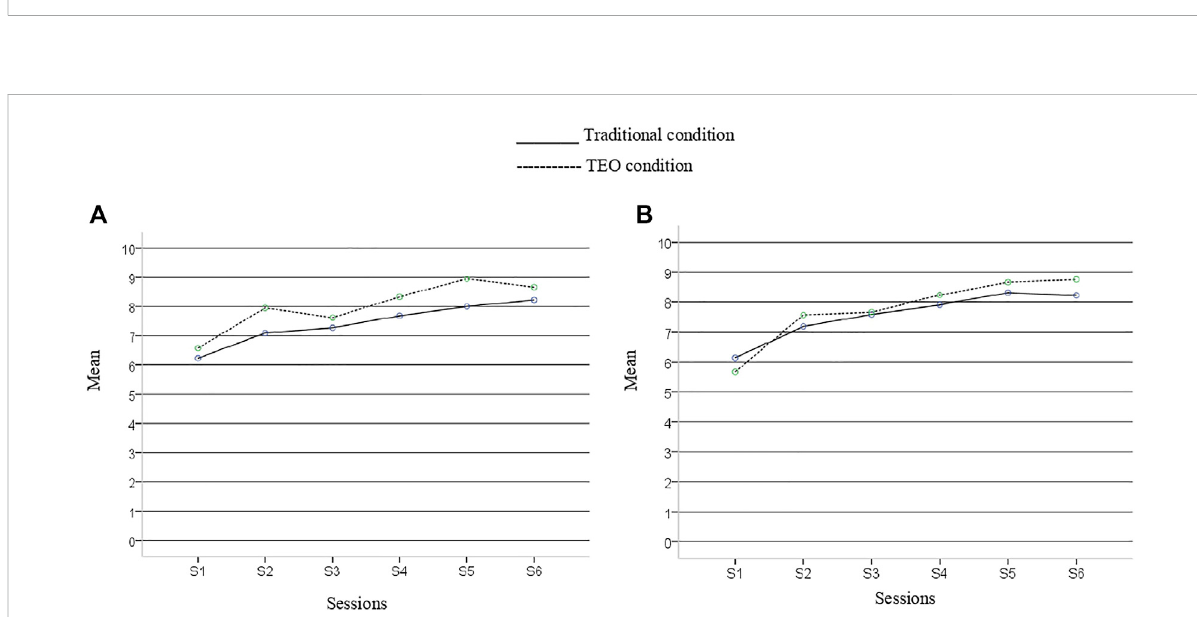
FIGURE 5 Negativeemotionforbothconditionsassessedbeforeandaftereachhomeworkassignmentsession.*Signi fi cantchangecomparedtothe fi rst session.